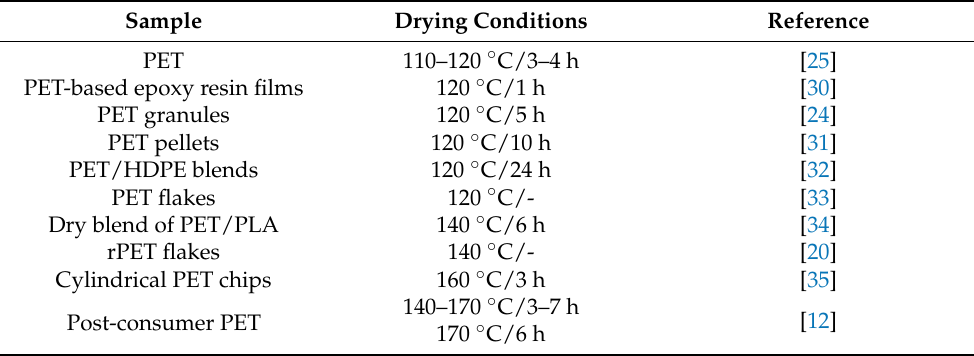
Table 2. Drying temperature of PET reported in various sources.